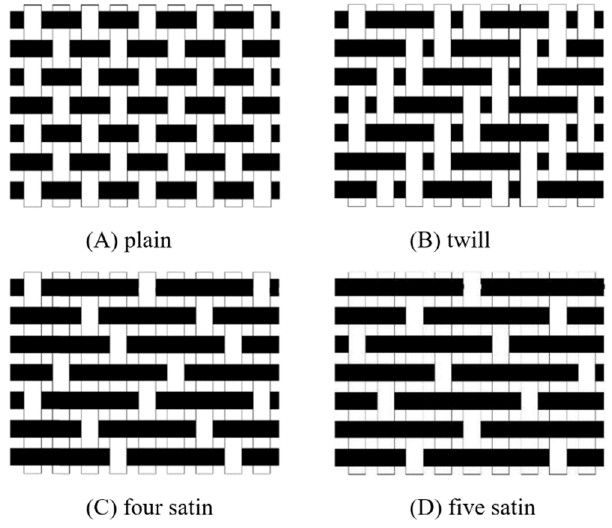
Figure 1. Diagram of various weave structures: ( A ) plain; ( B ) twill; ( C ) four satin; and ( D ) five satin.